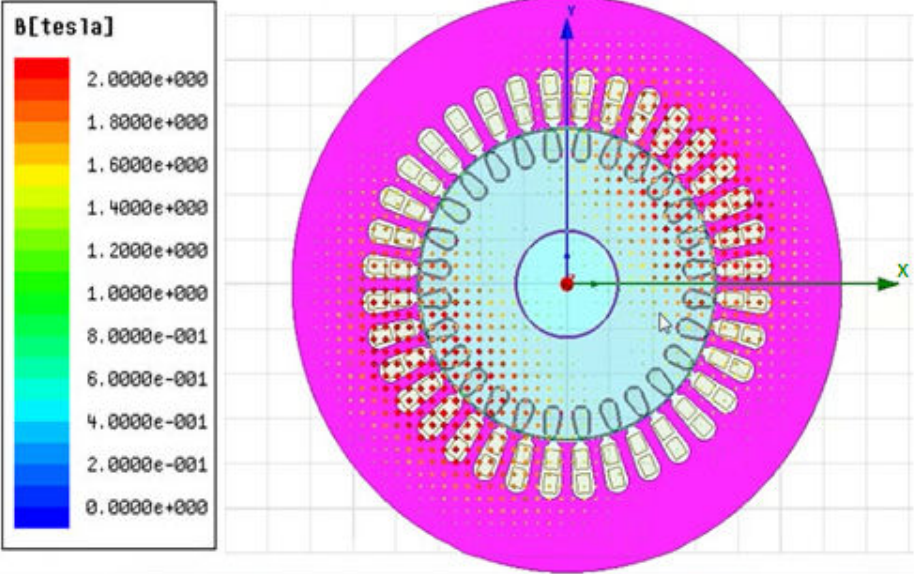
Figure 15. Flux density distribution of a SCSCRIM with full cross in Style D using the FEA